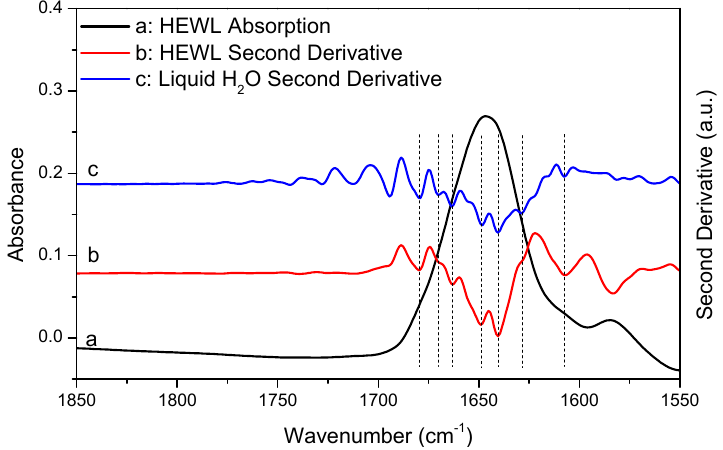
Figure 5. FTIR absorption (a) and second derivative (b) spectra of HEWL in D second derivative spectrum of liquid H O (c). Second derivative spectrum is displayed with 2 its resolved peaks pointing downwards and is in arbitrary unit (a.u.). Both of the spectra of O were subjected to 17-point smoothing. Spectral resolution: 4 cm − 1 HEWL and liquid H 2